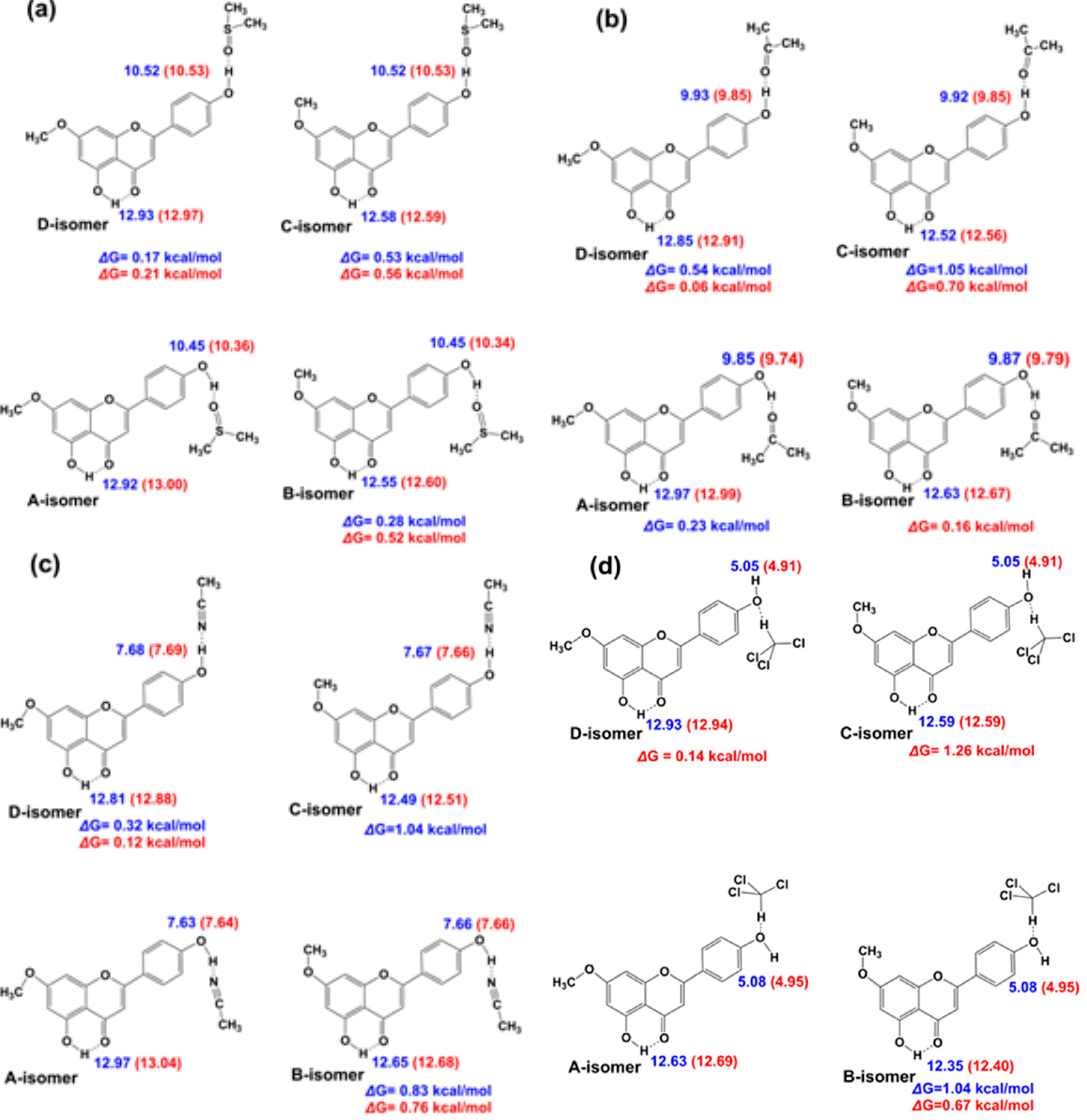
Figure 8. The effect of conformation of the C-7 OCH 3 and C-4 ′ OH groups on the chemical shifts of the C-4 ′ OH and C-5 OH protons for the 1:1 complexes of ( a ) genkwanin + DMSO; ( b ) genkwanin + Me 2 CO; ( c ) genkwanin + MeCN, and ( d ) genkwanin + CHCl 3 , with the use of DFT/B3LYP/6-31+G(d) (data in blue) and DFT/B3LYP/6-311++G(d,p) (data in red), level of theory. Adopted, with permission, from [46]. Copyright 2013, The Royal Society of Chemistry.